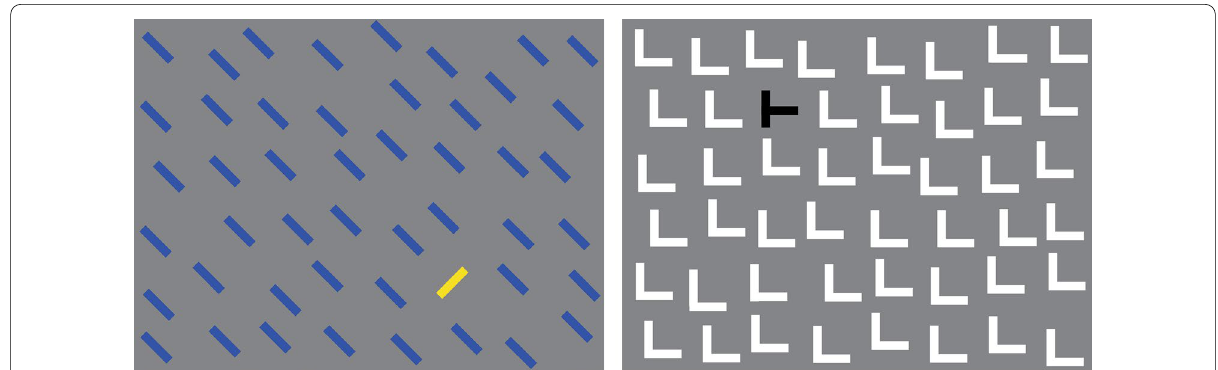
Fig. 3 Exemplar conventional visual search stimuli used in Experiment 2. See text for